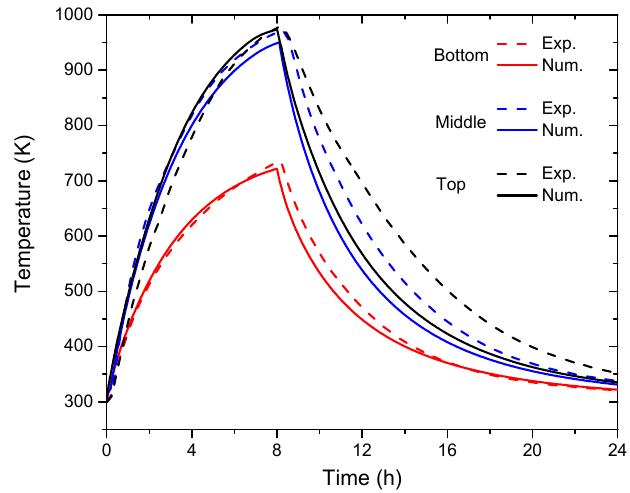
Figure 4. The evolution of the brick temperatures at the bottom, middle and top points of the experimental (Exp.) and numerical (Num.) results.